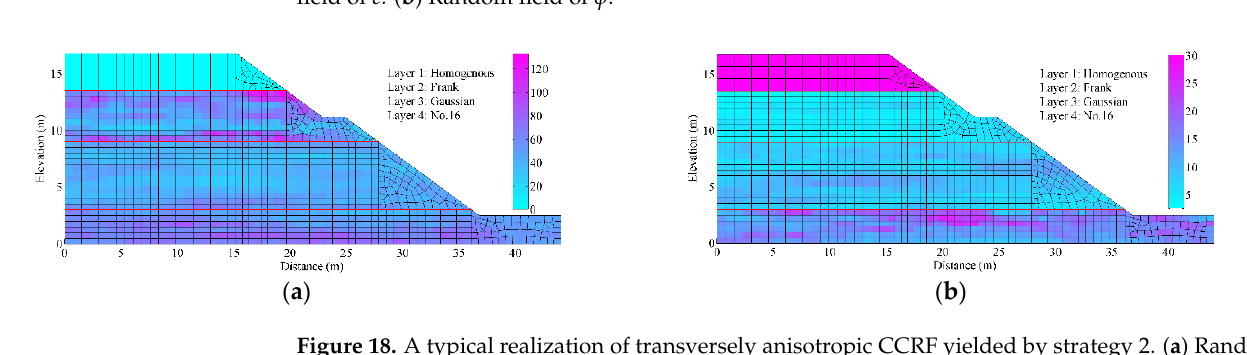
Figure 17. A typical realization of transversely anisotropic CCRF yielded by strategy 1. ( a ) Random field of c. ( b ) Random field of ϕ.